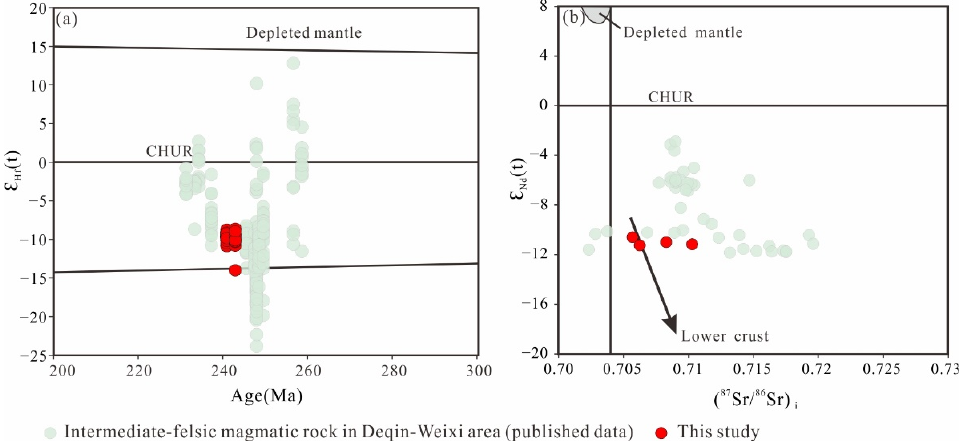
Figure 10. Zircon U-Pb age vs. ε Hf (t) ( a ) and ( 87 Sr/ 86 Sr) i vs. ε Nd (t) ( b ) for the Deqin–Weixi–Madeng intermediate-felsic magmatic rocks. Data source: Figure 10a [8,10,11,15]; Figure 10b [8,9,11–13].